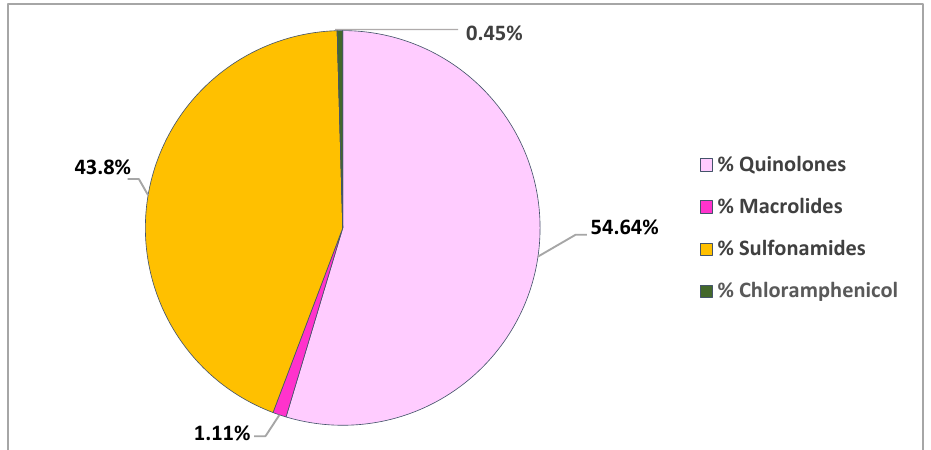
Figure 5. Distribution of antibiotic classes investigated in bivalves collected along American coasts.